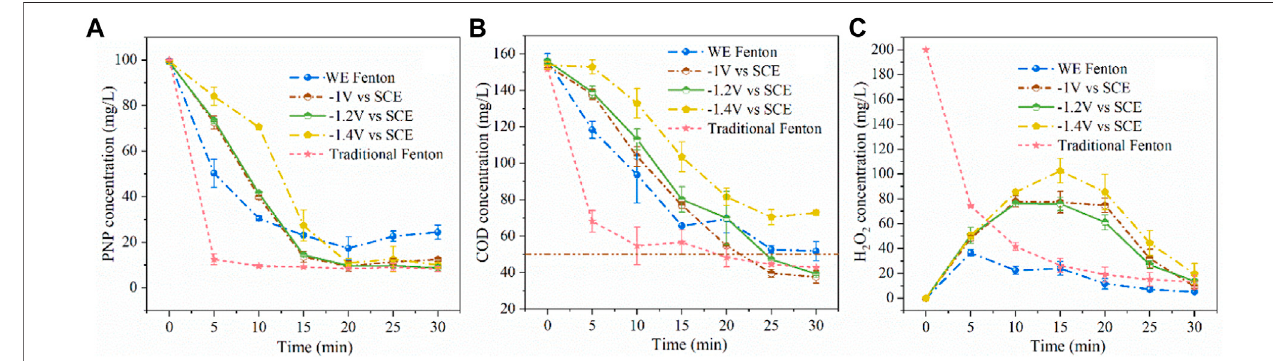
FIGURE5| ConcentrationvariationsofPNP (A) ,COD (B) ,andH 2 O 2 (C) duringthedegradationunderdifferentconditions(PNP (cid:1) 100 mg/L,Na 2 SO 4 (cid:1) 3 g/L,pH 0 (cid:1) 3.0).